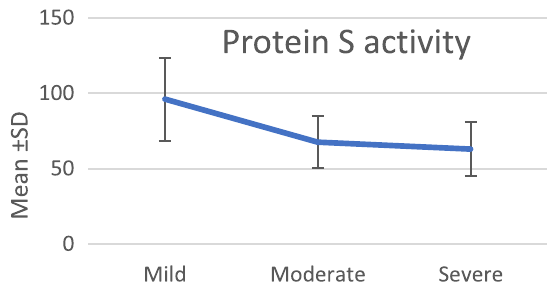
Fig. 2 Serum protein S in different disease severity